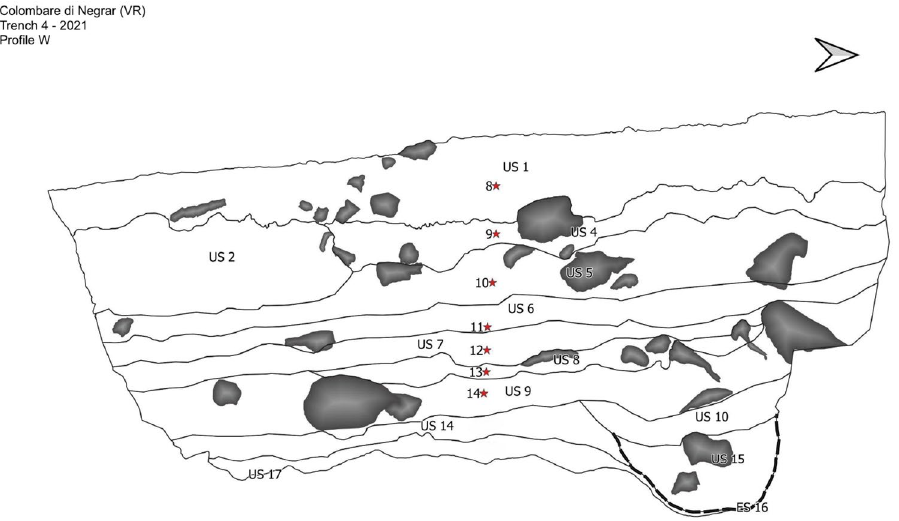
Figure 4. Sediment fractions related to the 7 samples of the 4–2021 trench (US1: sample 8; US4: sample 9; US5: sample 10; US6: sample 11; US7: sample 12; US8: sample 13; US9: sample 14; US14: sterile layer).